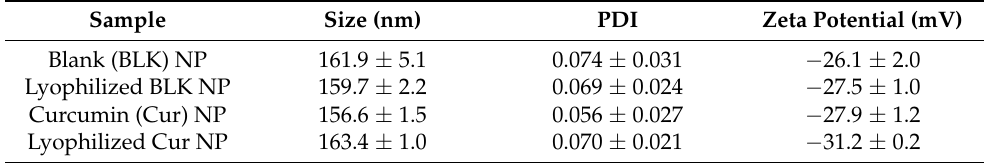
Table 1. Particle size, size distribution and surface charge of polymeric nanoparticles (NP) ( n = 3).